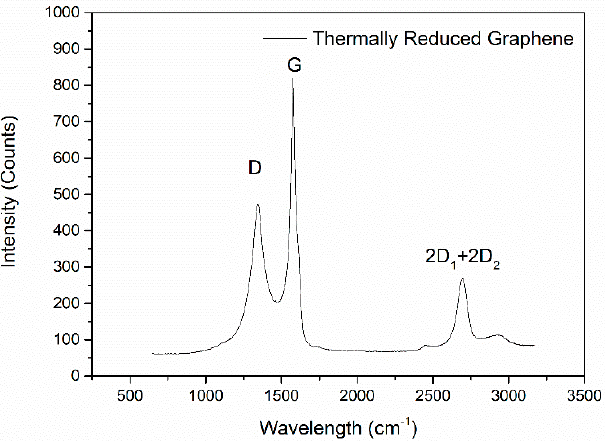
Figure 3. Example Raman spectrum of a thermally reduced graphene (by Hummer’s Method).